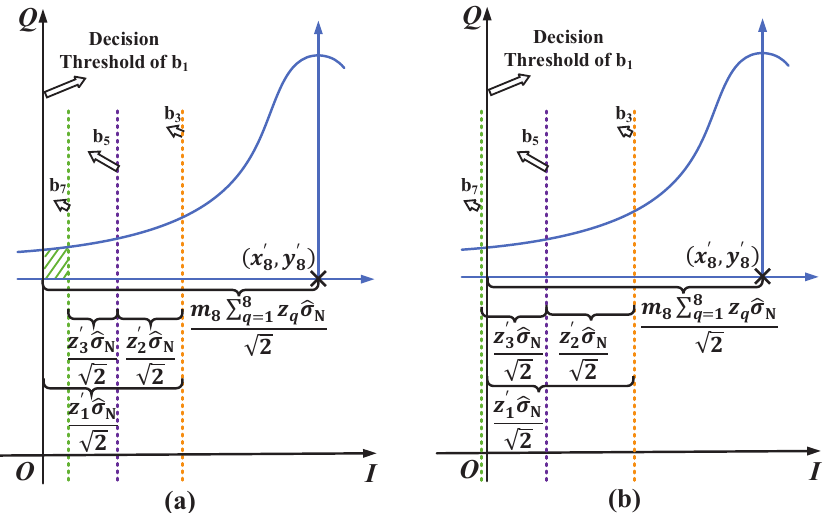
) for deriving BER expression of user 4 , y (cid:48) 8 8